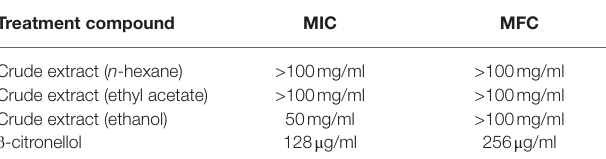
TABLE 1 | The minimum inhibitory concentration (MIC) and minimum fungicidal concentration (MFC) values against Candida albicans . Treatment compound